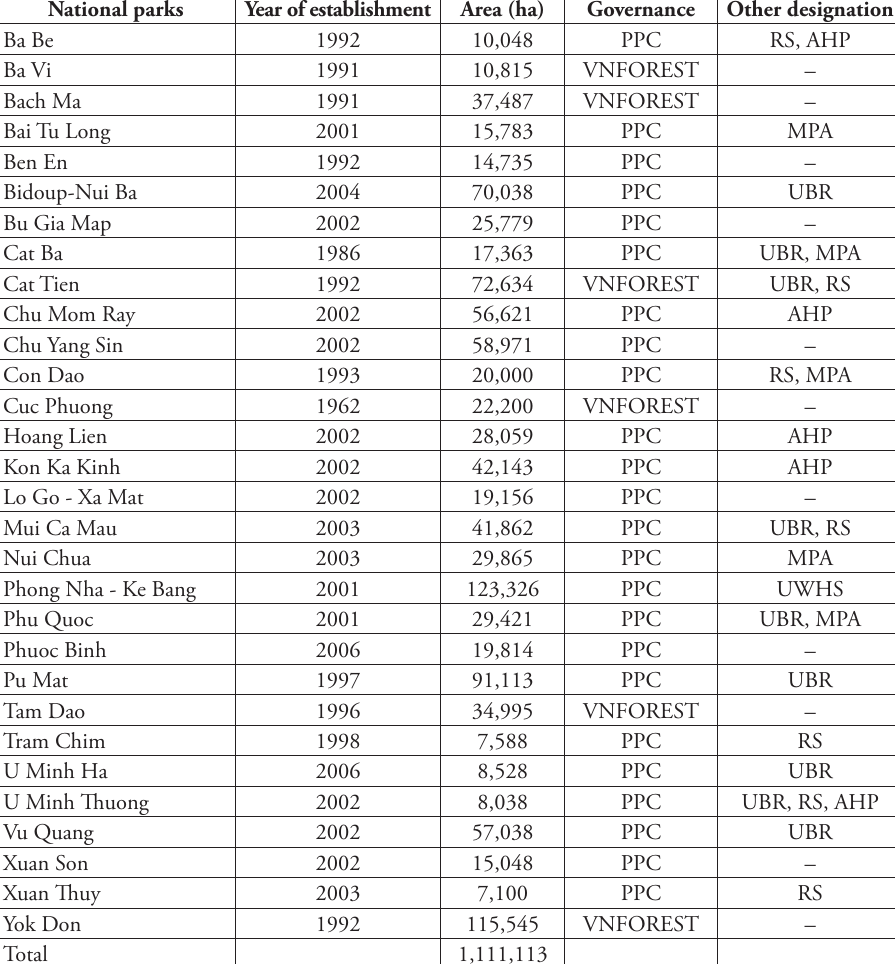
Table 1. Characteristics of national parks.